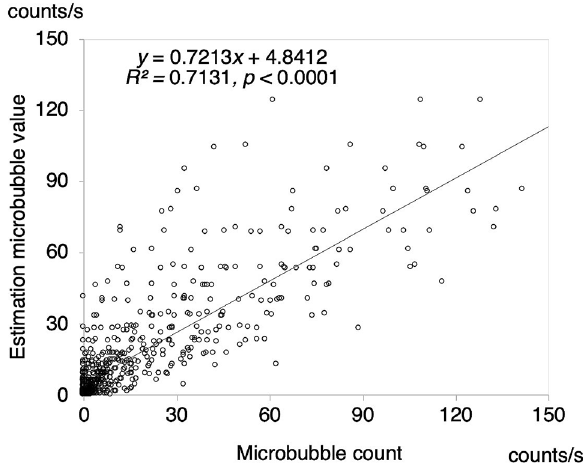
Figure 5. Estimation accuracy of the model in the case in which the blood viscosity factor was excluded. The estimation predicted the number of microbubbles is plotted against the number of microbubbles measured with a BC-100 microbubble